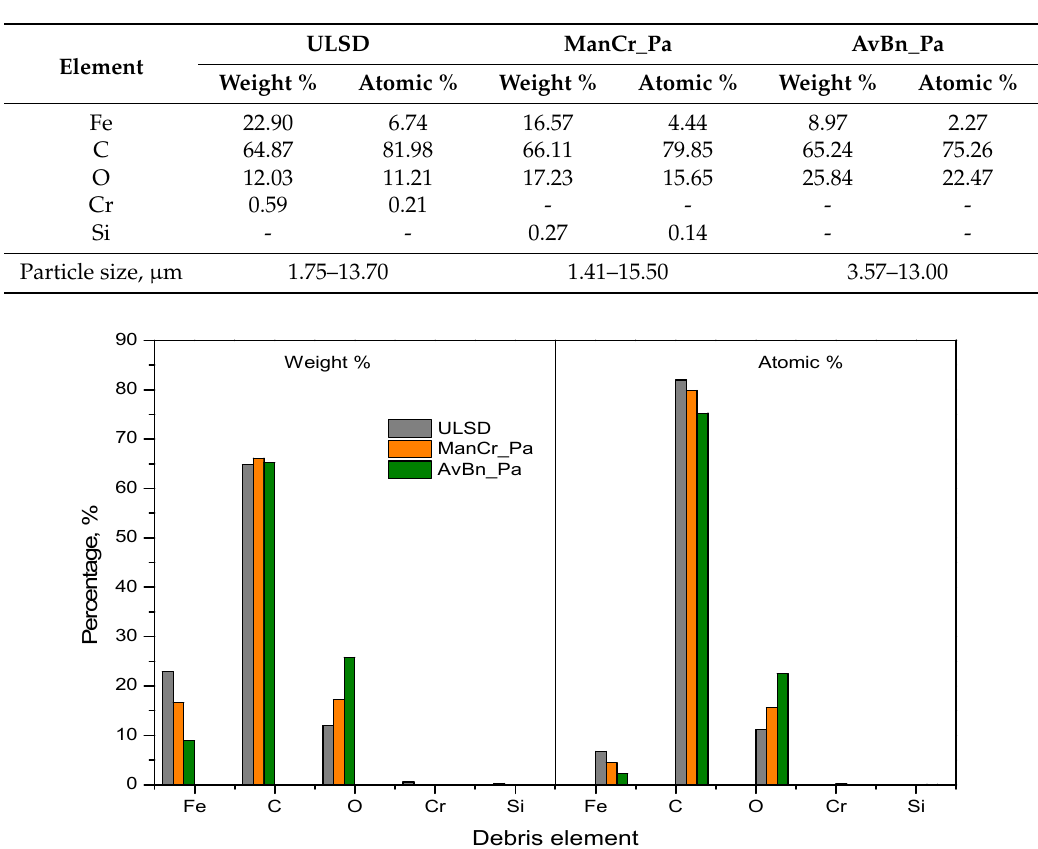
Table 5. Wear debris analysis of the filtering particles by SEM/EDX.